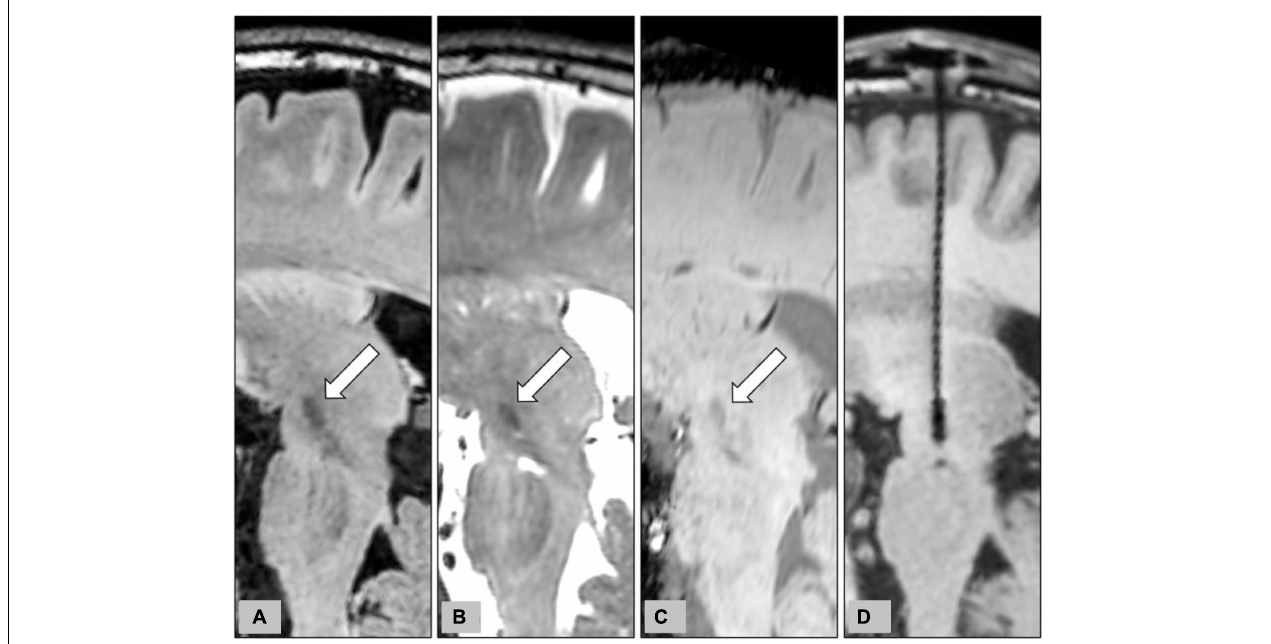
FIGURE 6 | Representative case to show the delineation of STN on different MR pulse sequences for the planning of STN-DBS surgery. The planned trajectory for the right STN-DBS lead was demonstrated on the oblique sagittal reconstruction of pre-operative 3D FLAIR (A) , T2WI (B) , and SWI (C) . The target structures, the STN, were indicated by white arrows on pre-operative images. The final position of the electrode was also shown on the oblique sagittal reconstruction of post-operative T1WI (D)